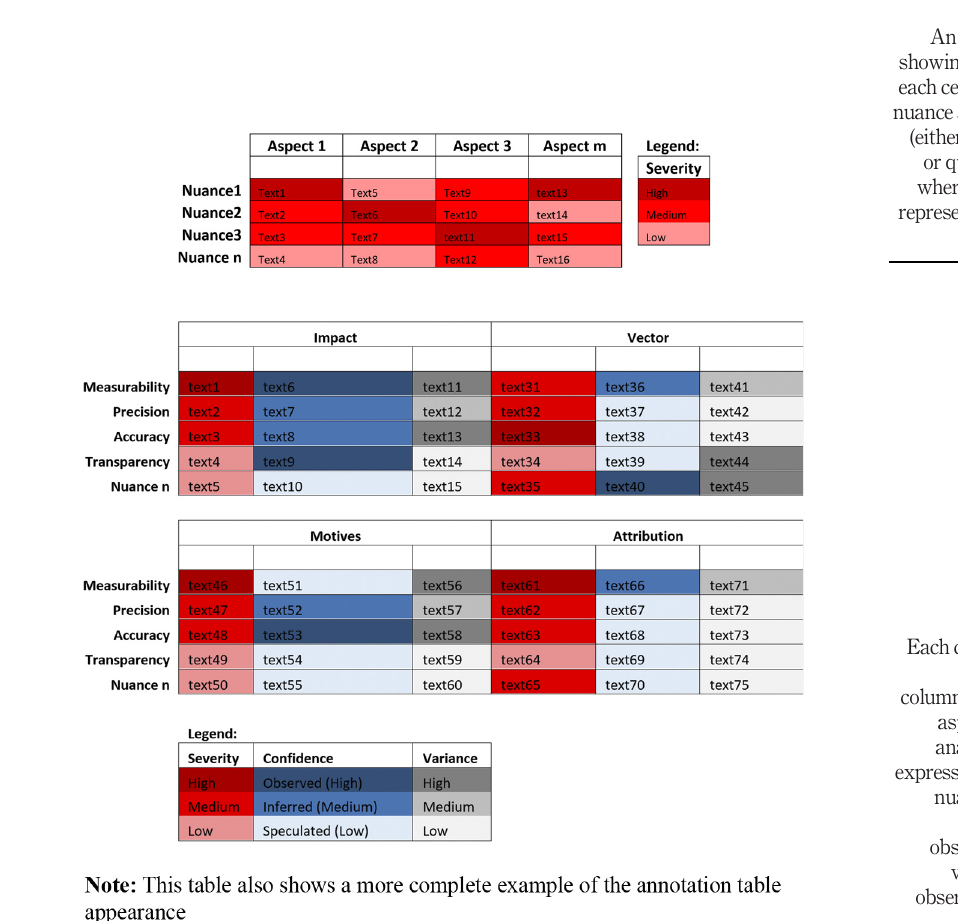
Figure 4. Each column can be split into sub- columns to highlight aspect factors, if analysts want